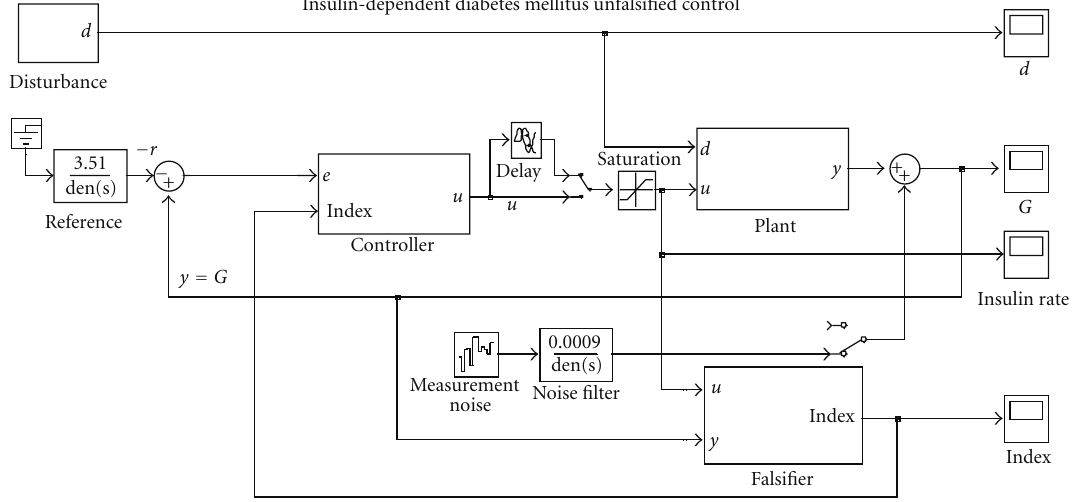
Figure 2: Unfalsified controller implementation. The reference signal is in (8), the disturbance and band-limited measurement noise are described in Section 4, a 30min. delay and actuator saturation (100mU/min) have also been added. G and u have been defined in Figure 1 and the index ( i = 1, ... ,5) indicates the controller to be used.